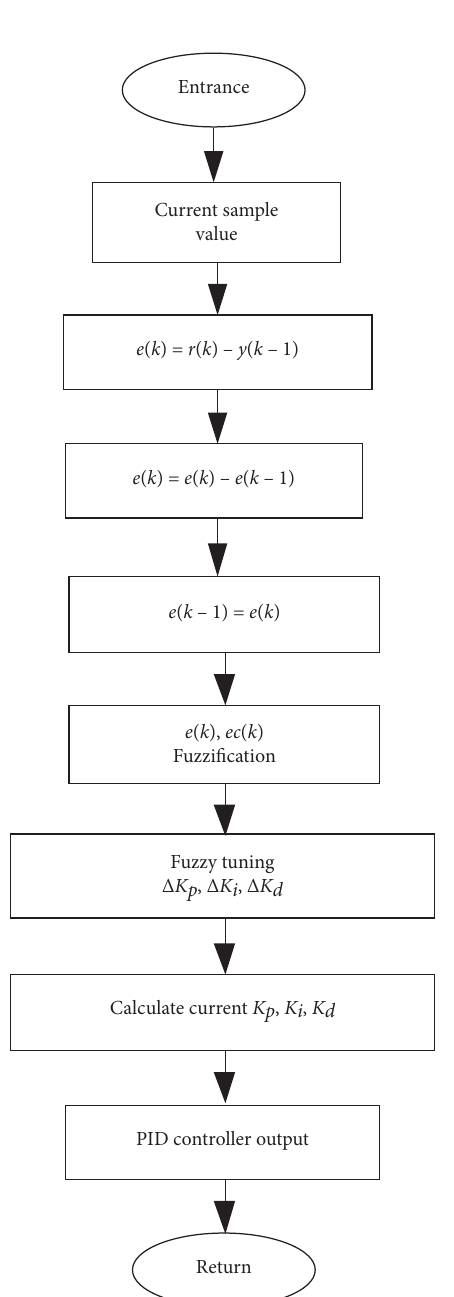
Figure 3: Flow chart of the fuzzy PID control algorithm.